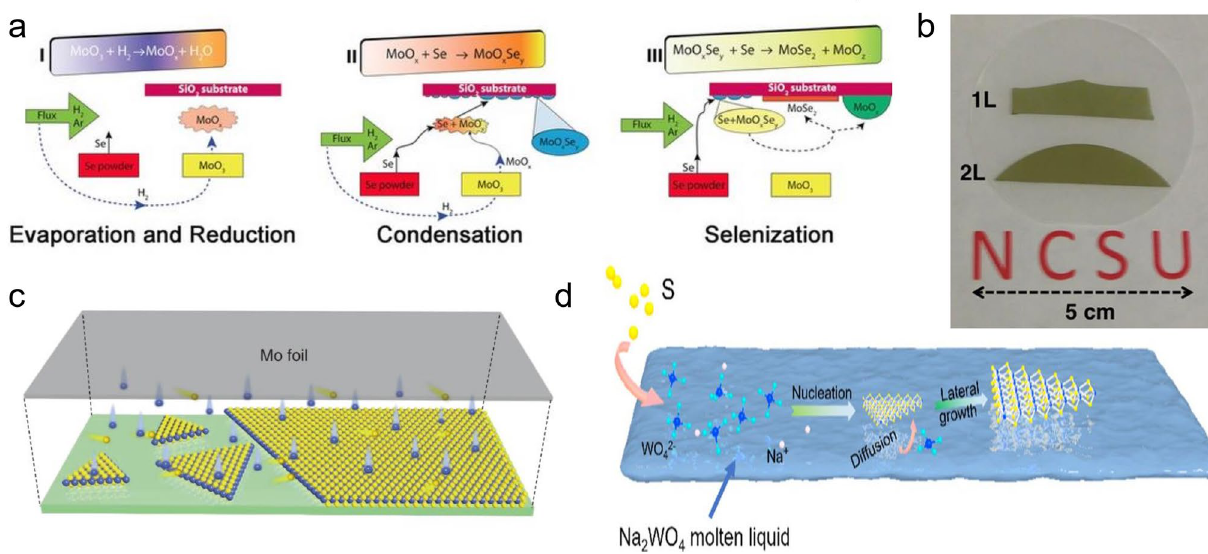
Fig. 4 The outcome of film influenced by precursor type. Growth mechanism by using a MoO 3 as the precursor [64], Copyright 2016, WILEY–